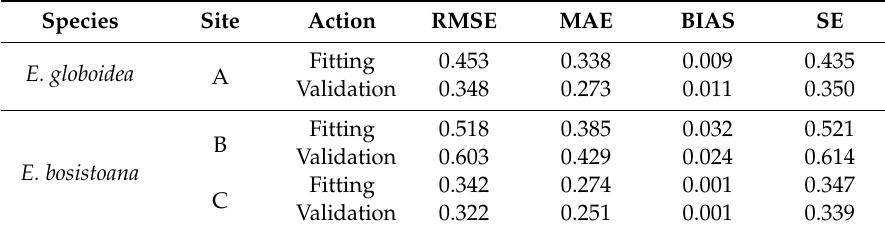
Table 4. Fit and validation statistics for the final height growth